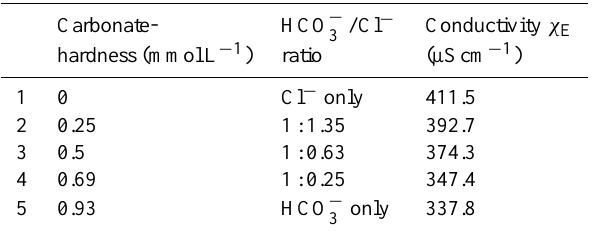
Figure 2. Measurement setup of Agilent 9294A for EIS measure- ments (Gruden and Kanoun, 2013b).